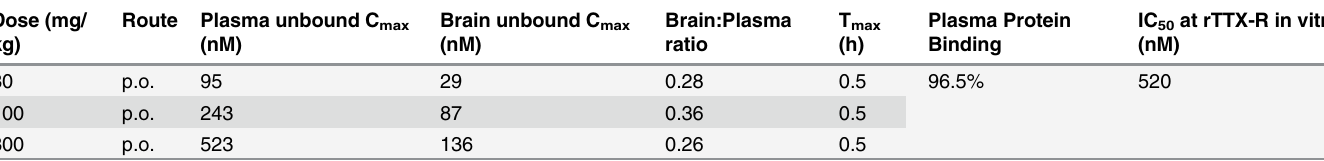
Table 1. Pharmacokinetic properties of PF-01247324 dosed in C57BL6 mice (n = 3 per dose level). Dose (mg/ Route Plasma unbound C max kg)